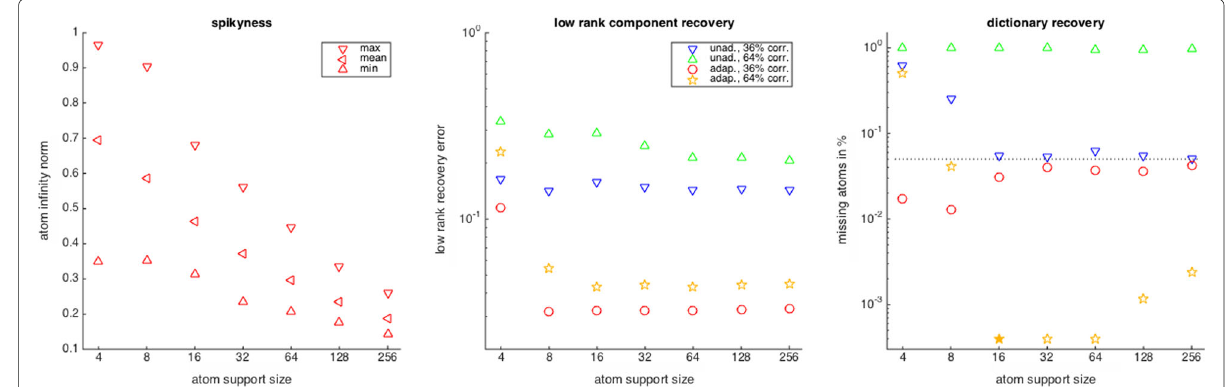
Fig. 4 Atom spikiness (left) as well as recovery of the random low-rank component (middle) and random dictionary (right) of the corruption adapted versus the unadapted learning algorithms with varying atom support sizes. Two types of random erasure patterns leading to 36 and 64% corruption are